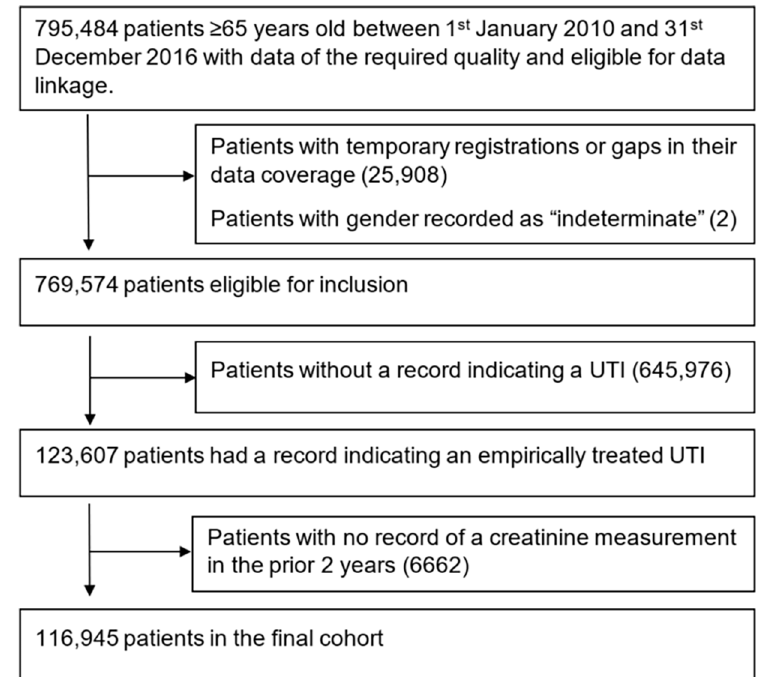
Fig 1. Flow of patients from initial identification in the database through to final cohort. UTI, urinary tract infection.